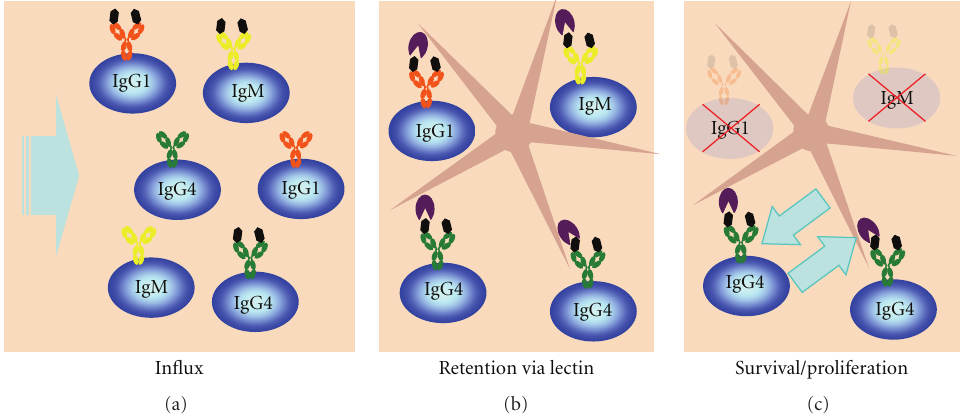
Figure 1: Proposed model of B-cell infiltration into a ff ected tissue. (a) B cells from the circulation enter the inflamed tissue. (b) Di ff erential glycosylation of IgG4-switched B cells allows retention and activation of this cell type via an as-yet-unidentified lectin on the stellate cell. (c) In this model, the local environment of the a ff ected tissue will further promote survival/proliferation of IgG4-switched B cells due to a tolerogenic environment that may in part be created via signals from the IgG4 B cells